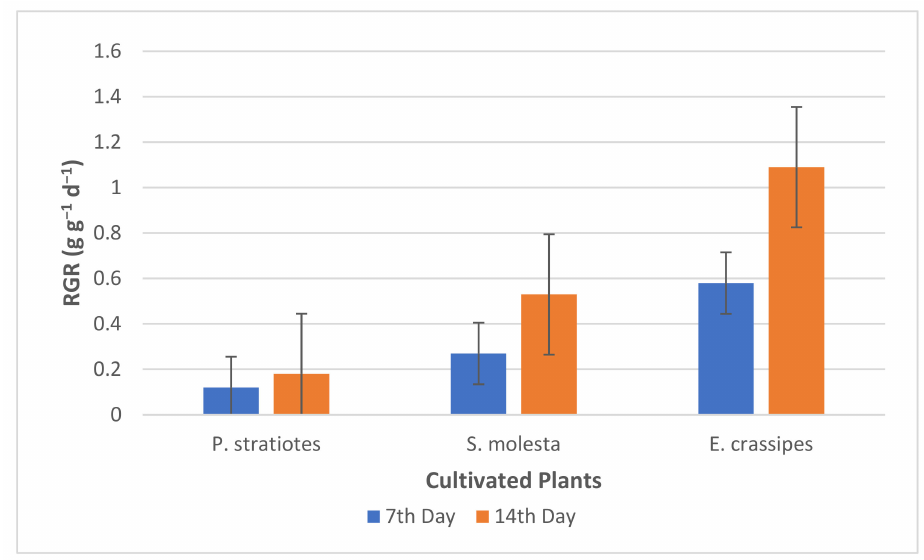
Figure 7. Graph of RGR (g g − 1 d − 1 ) against cultivated plants at 6 h retention time.